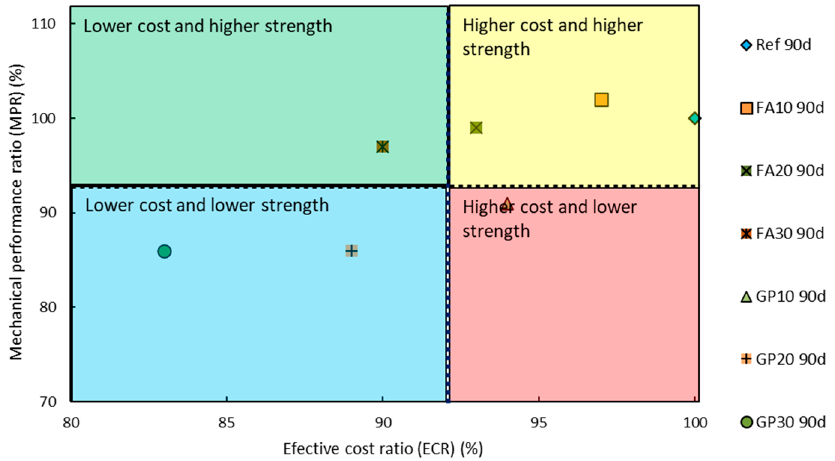
Figure 20. Mechanical performance ratio ( MPR ) and effective cost ratio ( ECR ) values after 90 days with regards to the series of the air-cured hardened cementitious mortars.